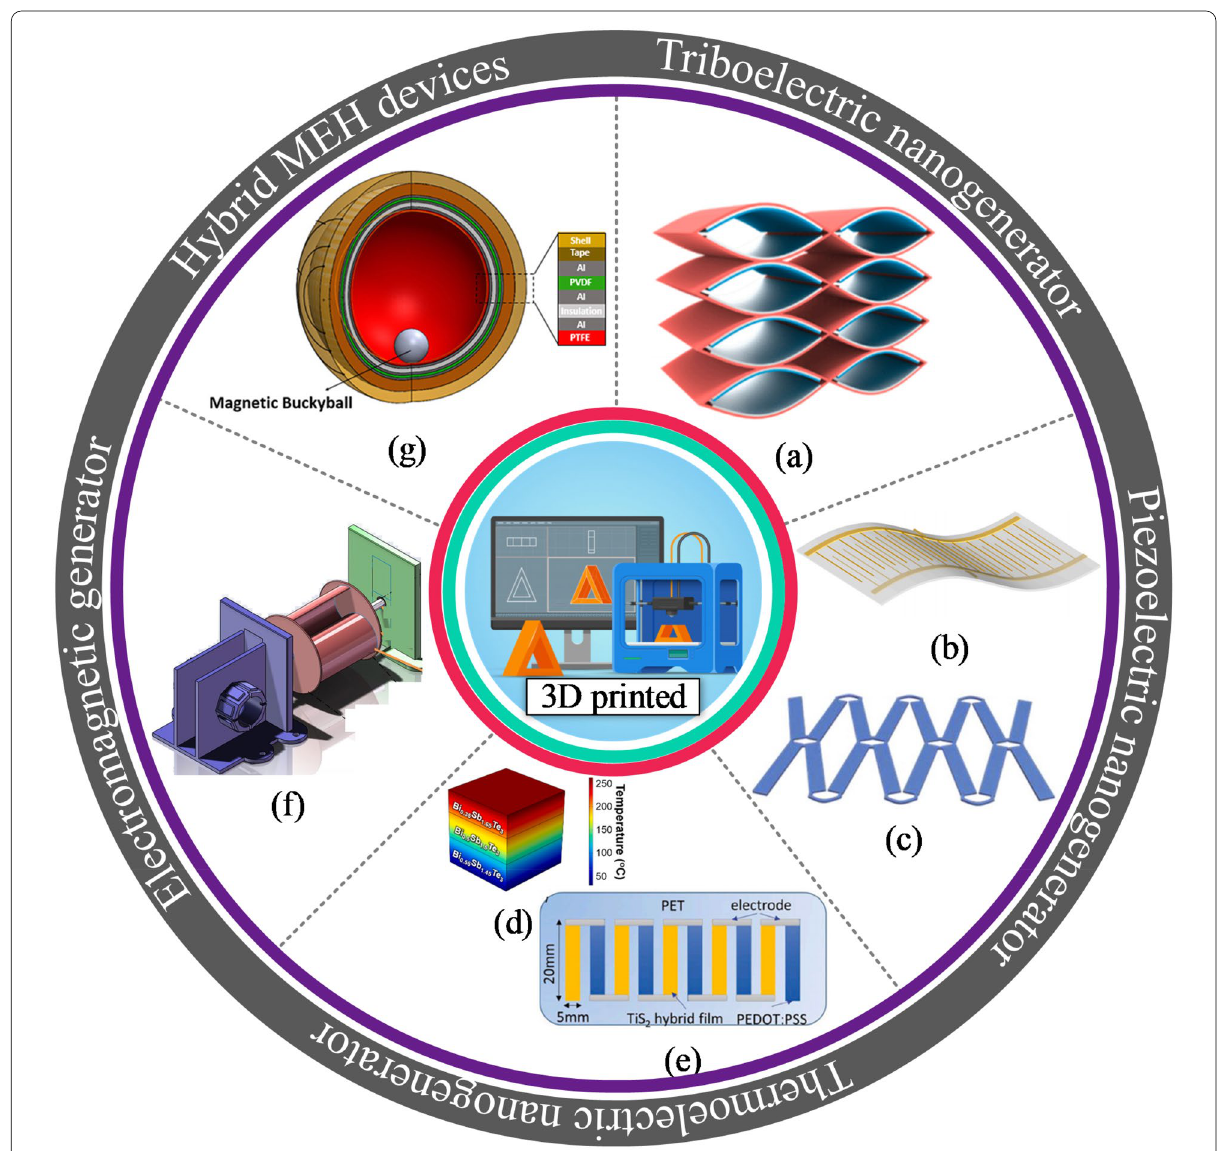
Fig. 6 Classification of 3D printed energy harvesting devices based on working principle a 3D printed flexible triboelectric nanogenerator as a self-powered electro-Fenton degradation system [29] b 3D-printed piezoelectric device for self-powered sensor application [33] c 3D-printed stretchable piezoelectric nanogenerator with non-protruding kirigami structure [34] d 3D printed BiSbTe thermoelectric generator [35] e Thermoelectric device composed of a p-type and n-type organic superlattice film deposited onto the flexible PET substrate [36] f 3D printed miniature electromagnetic energy harvester driven by airflow [26] g 3D printed hybrid 3D activity inertial sensor based on EMG, TENG and PENG nanogenerators [37] (Images are re-used with the permission of the